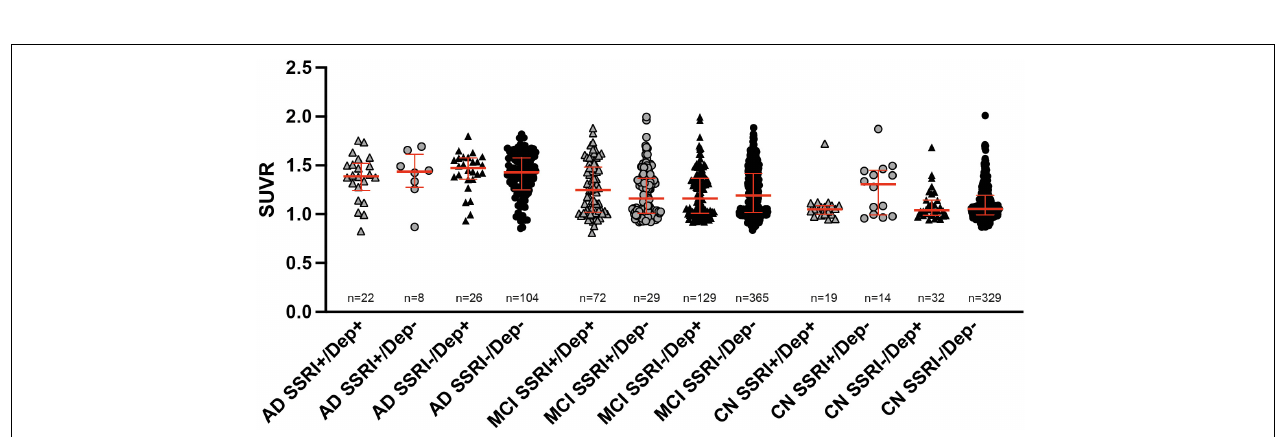
FIGURE 3 | 18 F-Florbetapir uptake in SSRI-treated and untreated subjects with and without history of depression. No significant differences between SSRI-treated and untreated subjects with or without depression were detected regardless of the diagnosis (Kruskal–Wallis test; red bars represent median ± interquartile range. AD, Alzheimer’s disease; MCI, mild cognitive impairment; CN, cognitively normal controls.